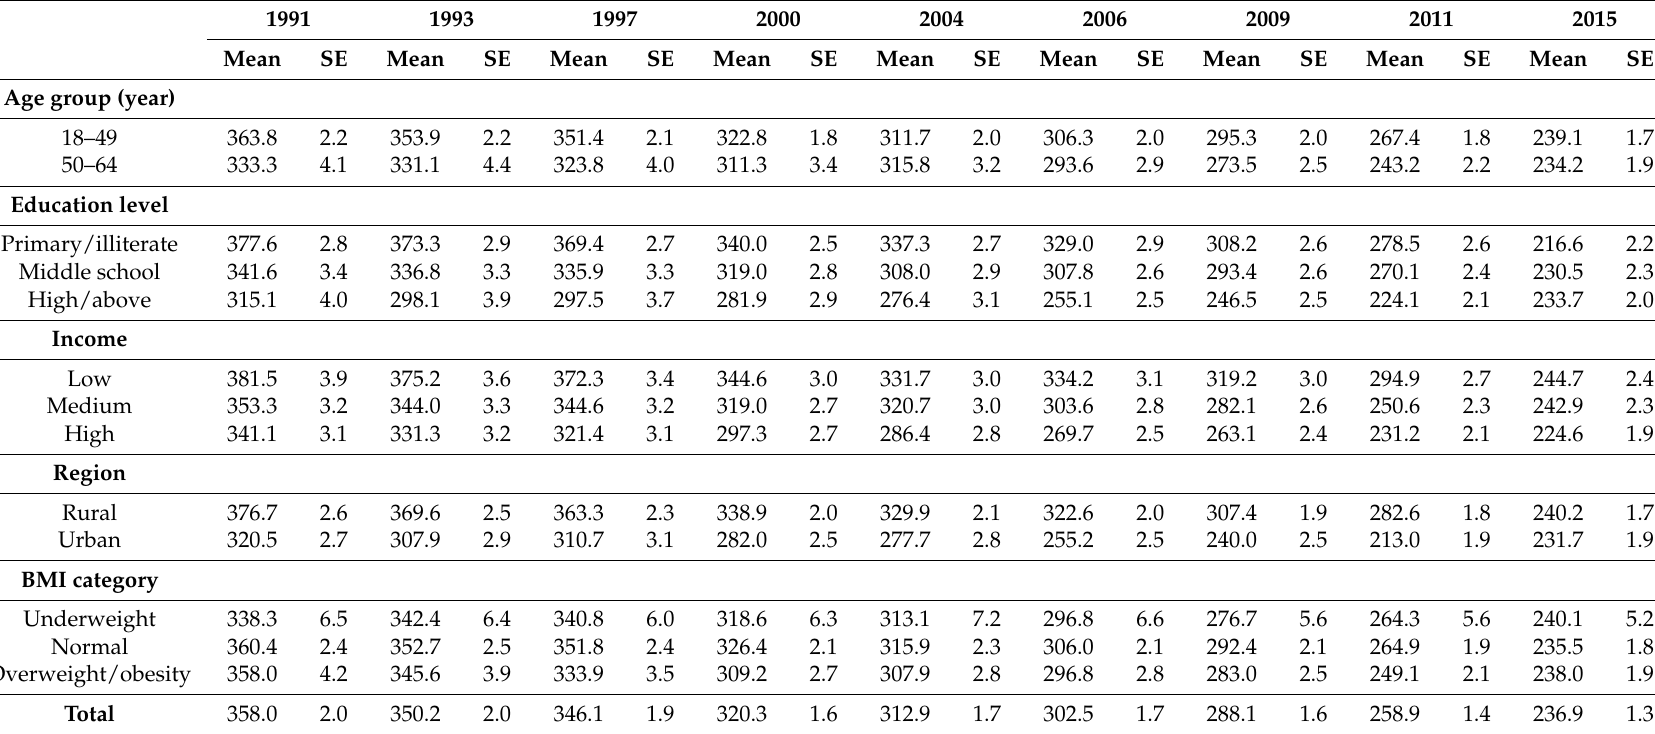
Table 4. Daily carbohydrate intake (g), by age, education, work status, income and geographical region, in Chinese women from 1991 to 2015 1,2